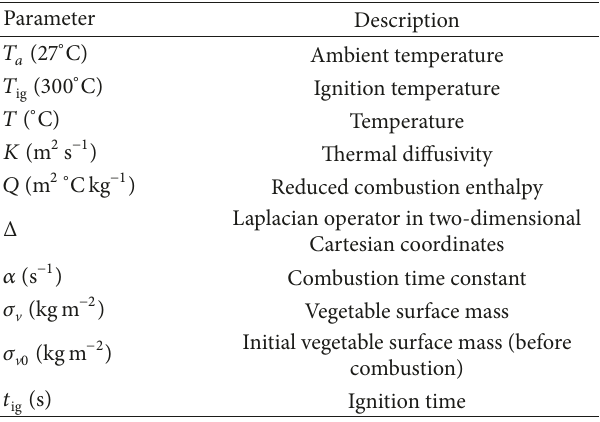
Table 1: Nomenclature of fire spread model parameters